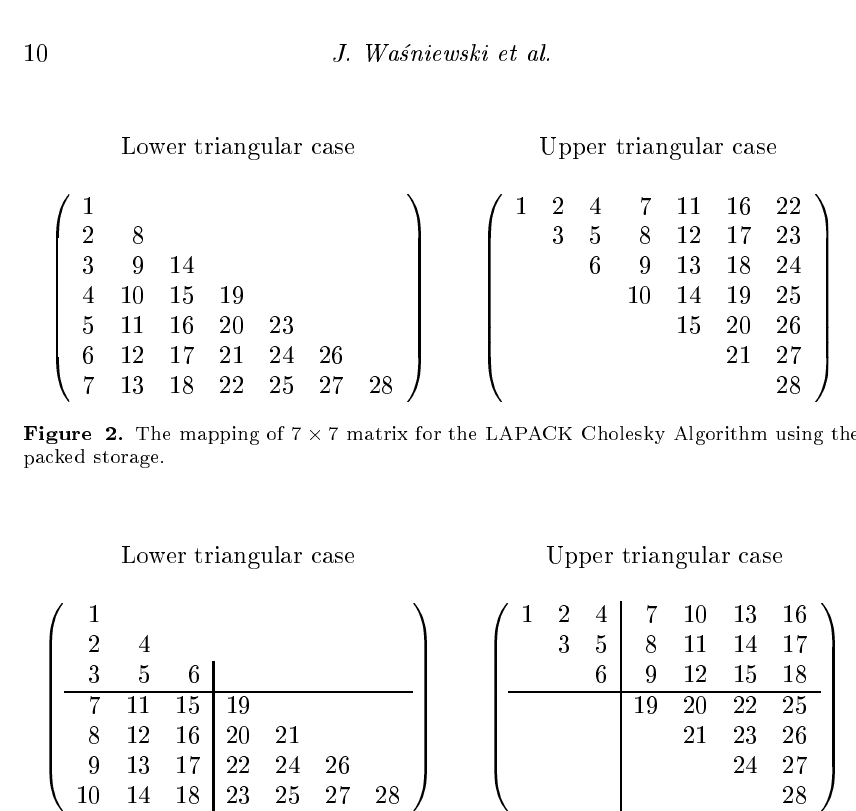
Figure3.Themappingof7(cid:2)7matrixfortheLAPACKCholeskyAlgorithmusingthe